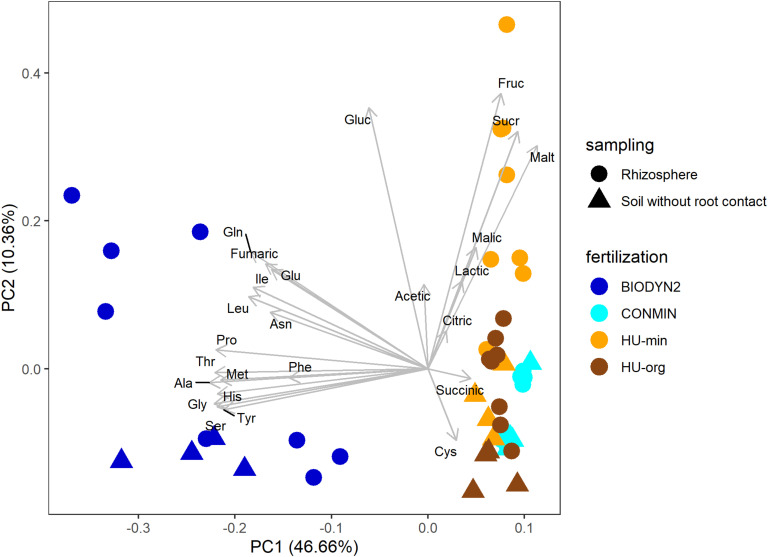
Biplot of PCA comparing patterns of organic compounds in the rhizosphere soil solution of lettuce (cv. Tizian) and in soil without root contact under long-term organic (HU-org, BIODYN2) or mineral (HU-min, CONMIN) fertilization. Ala, alanine; Asn, asparagine; Cys, cysteine; Gln, glutamine; Gly, glycine; Glu, glutamic acid; His, histidine; Ile, iso-leucine; Leu, leucine; Phe, phenylalanine; Pro, proline; Met, methionine; Ser, serine; Thr, threonine; Tyr, tyrosine; Fruc, fructose; Gluc, glucose; Malt, maltose, Sucr, sucrose; Acetic, acetate; Citric, citrate; Fumaric, fumarate; Malic, malate; Succinic, succinate; Lactic, lactate.